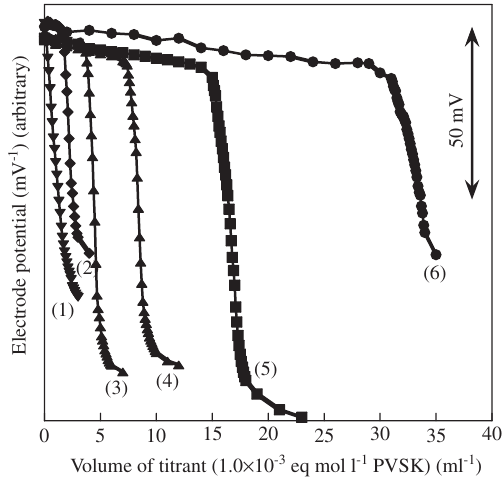
Figure 3 Potentiometric titration curves for the PHMB-HCl solutions (40.00 ml) containing 1.0 × 10 -2 m HCl with 1.0 × 10 -3 eq mol l -1 PVSK standard solution. Concentration of PHMB-HCl: (1) 0, (2) 2.0 × 10 -5 , (3) 4.0 × 10 -5 , (4) 1.0 × 10 -4 , (5) 2.0 × 10 -4 , (6) 4.0 × 10 -4 eq mol l -1 . Titrant: 1.0 × 10 -3 eq mol l -1 PVSK solution. Indicator ion: 1.0 × 10 -5 m calibration curve equations are Y = 0.7779 × 10 5 X -0.0198 ( γ = 0.9995) for PHMB-HCl solutions in the concentration range from 2.0 × 10 -5 to 4.0 × 10 -5 eq mol l -1 and Y = 0.9195 × 10 6 X -0.0940 ( γ = 0.9993) for PHMB-HCl solutions in the con- centration range from 1.0 × 10 -6 to 1.2 × 10 -5 eq mol l -1 , respec- tively. Here, Y is the end point volume and X the equivalent molar concentration of the PHMB-HCl solution. The RSDs